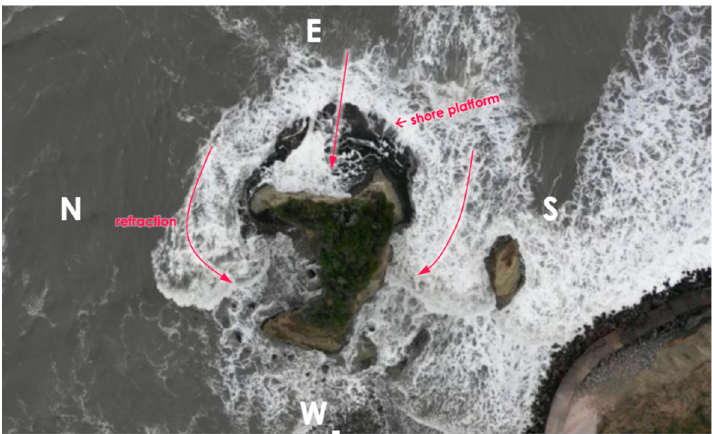
Figure 7. A screenshot of the video with an orthogonal view of the Suzume-Jima island from a UAV ca. 100 m above the ground. The trajectories of the tidal waves are indicated by red arrows, showing the direct attack against the eastern face of the island and indirect attacks against the northern and southern faces with the refraction of the waves.